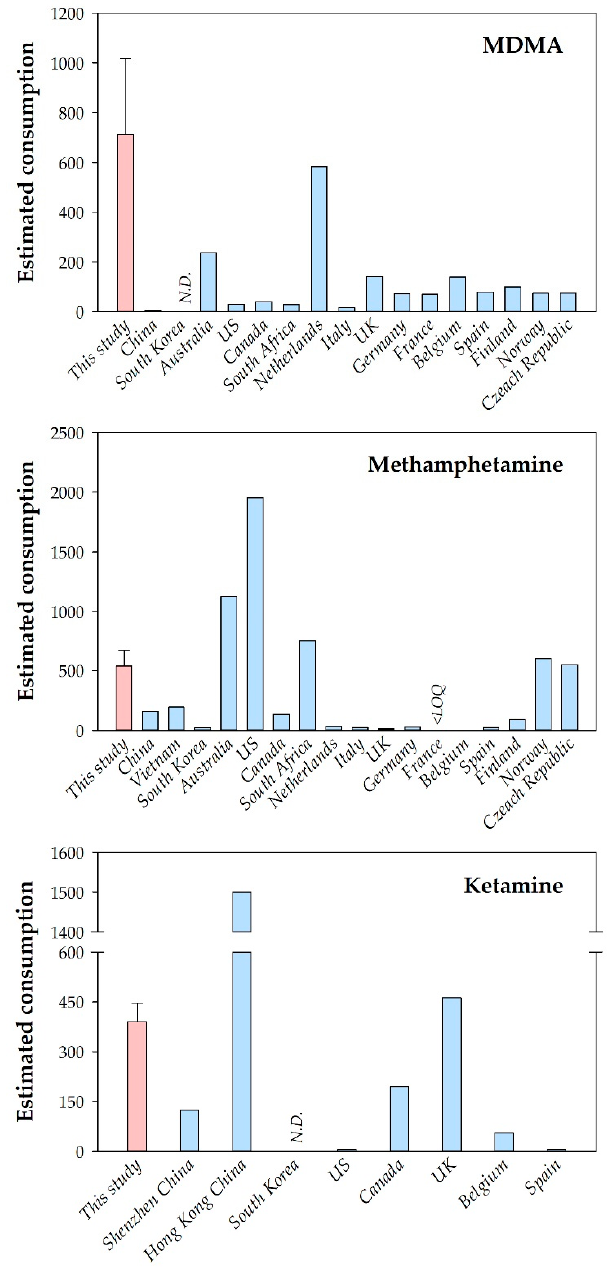
Figure 1. Estimated methamphetamine, MDMA and ketamine consumptions (mg / 1000 inh / d) in this study and other countries [3,12,35 – 46].